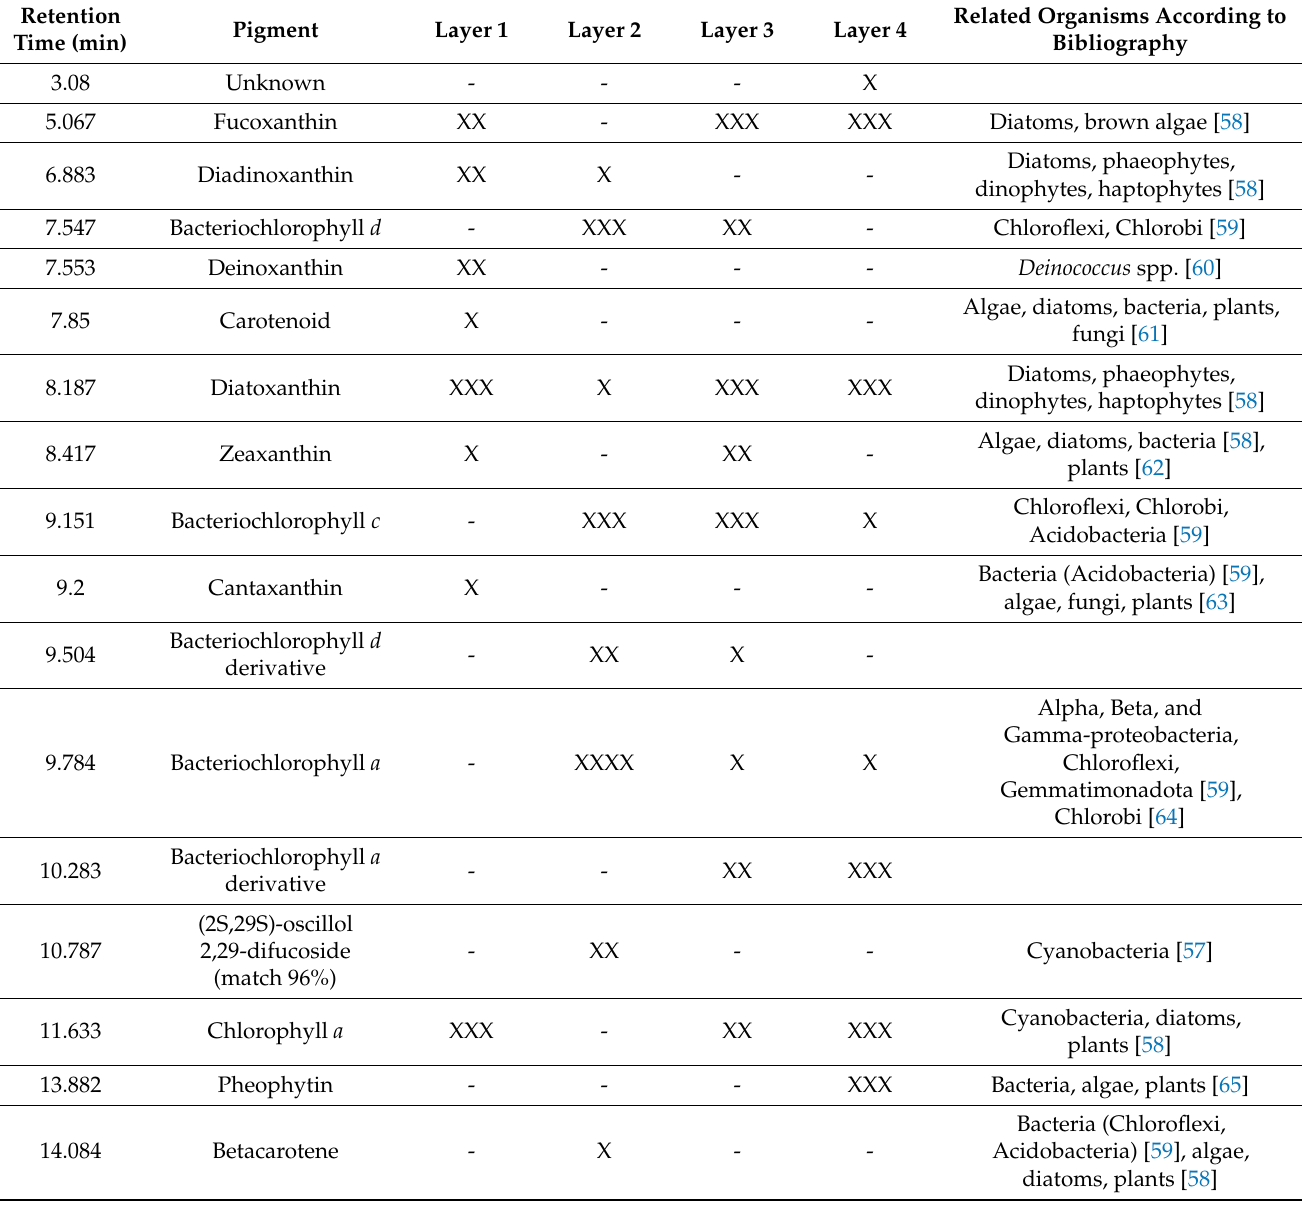
Table 1. Pigment content of the layers of the microbial mat detected by high-performance liquid chromatography (HPLC)